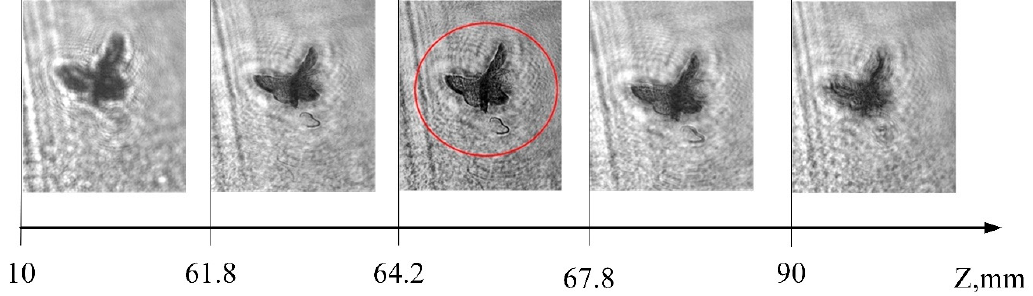
Figure 2. Restored images of planes of the ZnGeP 2 plate located at distances Z from the photodetector matrix.